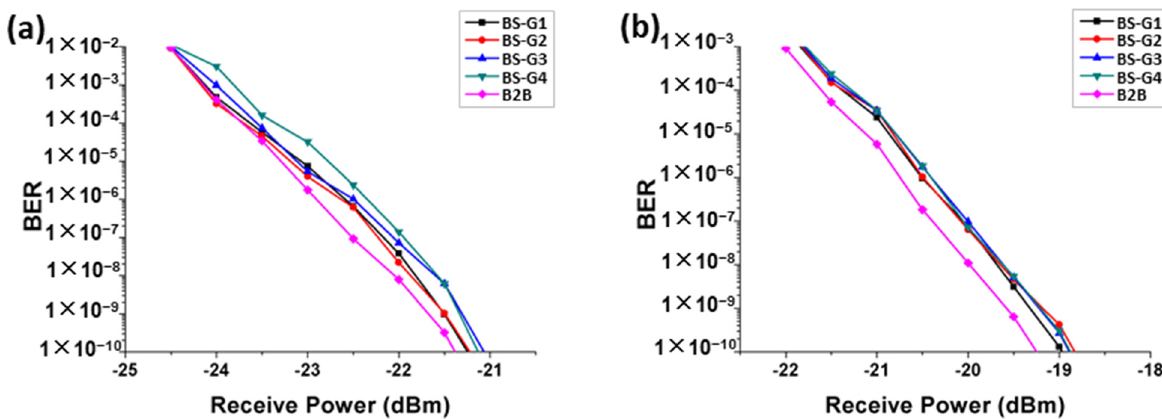
Figure 7. BER performances for the BSs in BS-Group1 to BS-Group4 in ( a ) B2B and downlink transmissions scenarios as well as in ( b ) B2B and uplink transmissions scenarios .